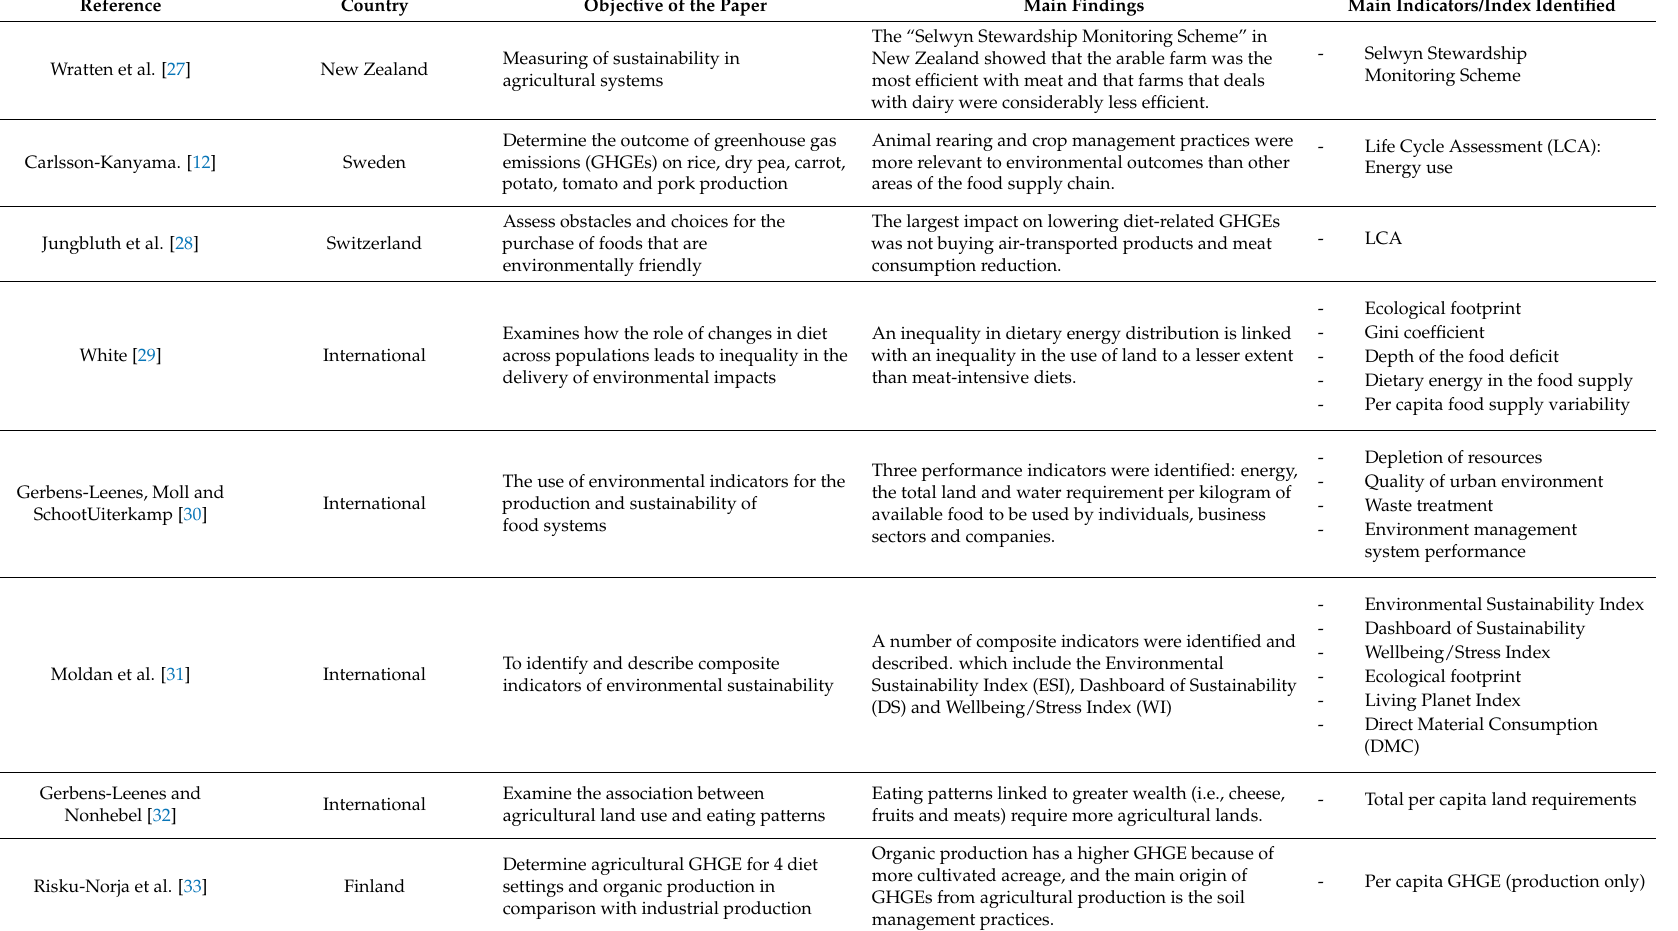
Table 1. The environmental indicators used for assessing a sustainable